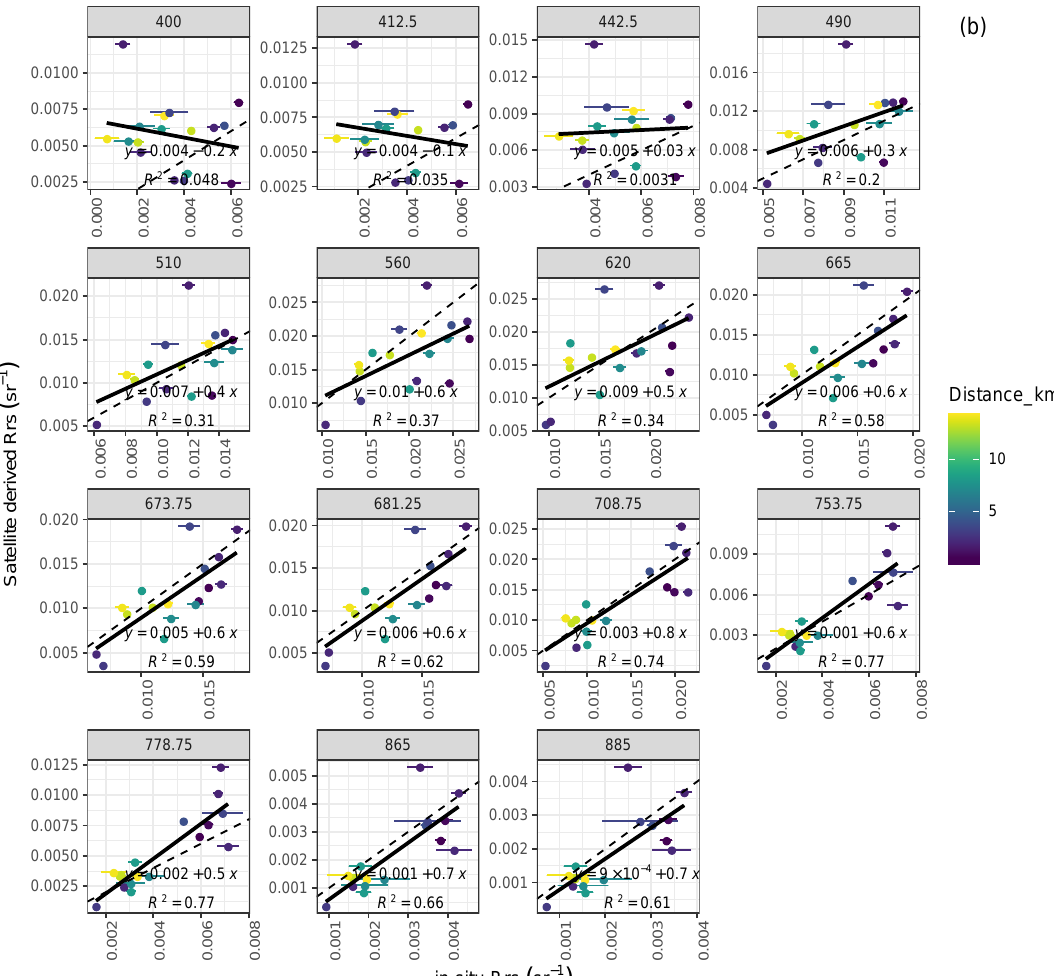
Figure A5. Correlation between in situ measured ( x -axis) vs ALTNN-derived rho ( y -axis) on OLCI bands. Upper figure ( a ) shows validation results on all data and lower ( b ) after filtering the in situ data based on the 5% criteria at least in one band. For each match-up point, the color shows the distance from the